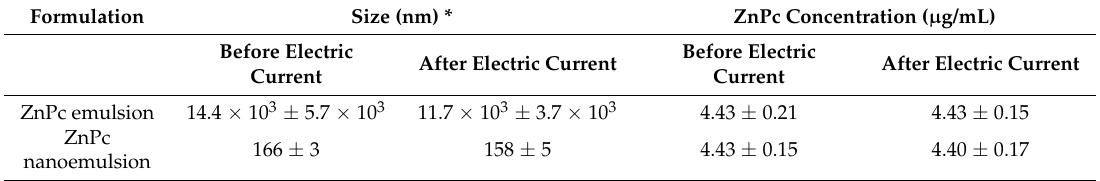
Table 3. Stability of the formulations in the presence of the electric current at 0.5 mA for 60 min. Formulation Before Electric Current